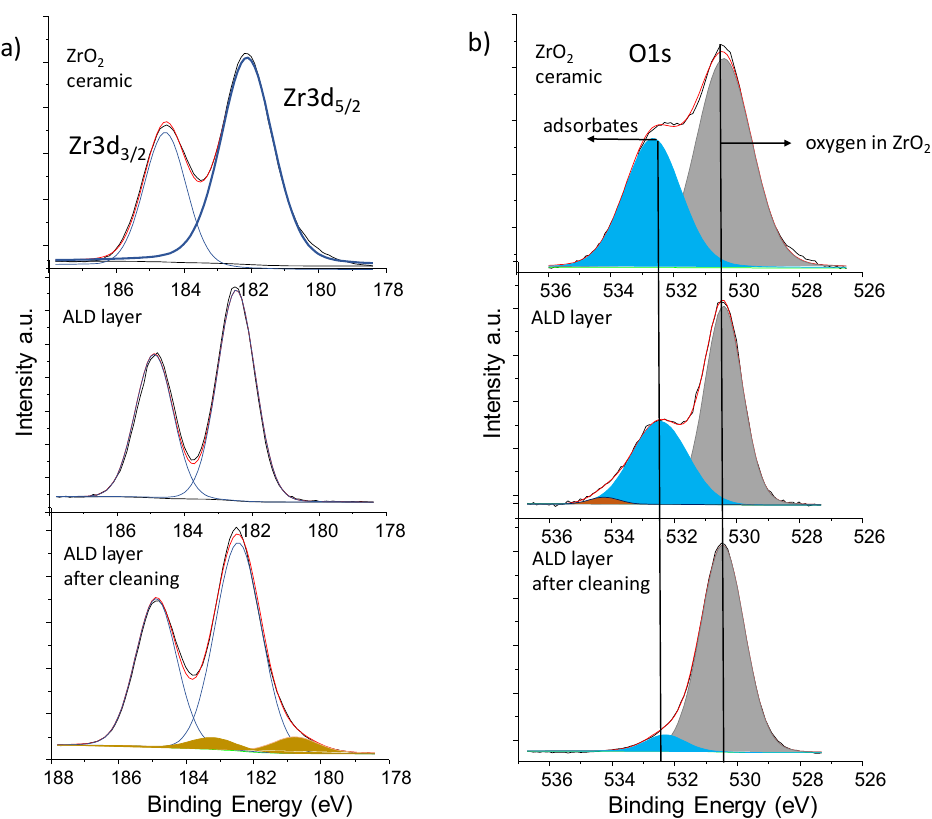
Figure 9. The Zr3d doublet and O1s electronic states obtained for ( a ) “as received” and ( b ) after cleaning by Ar+ ion treatment in UHV conditions sample. The Zr3d and O1s core lines recorded for ceramic were added for comparison.